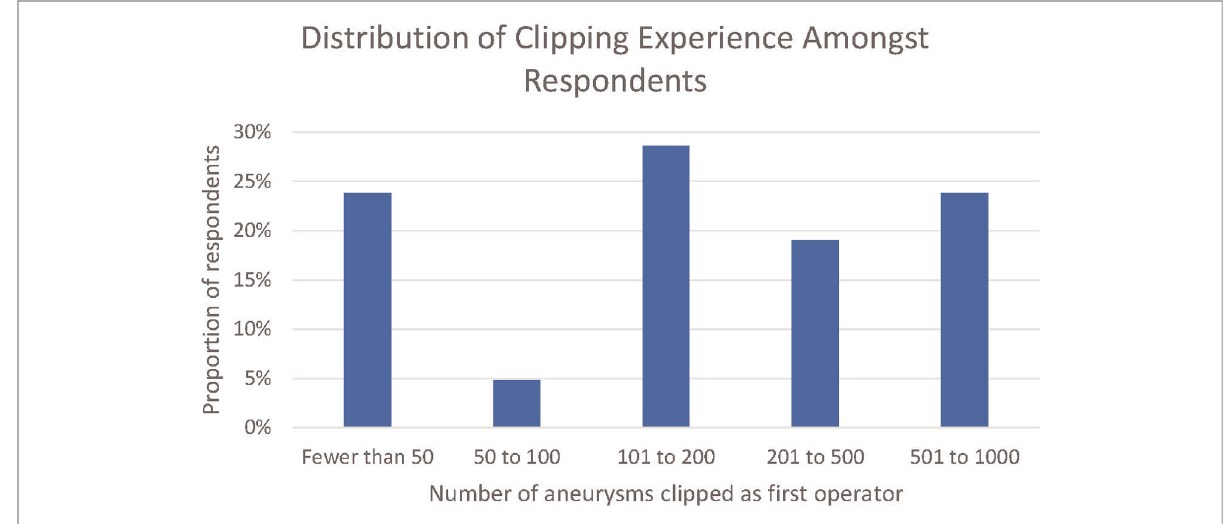
FIGURE 1 Distribution of clipping experience amongst